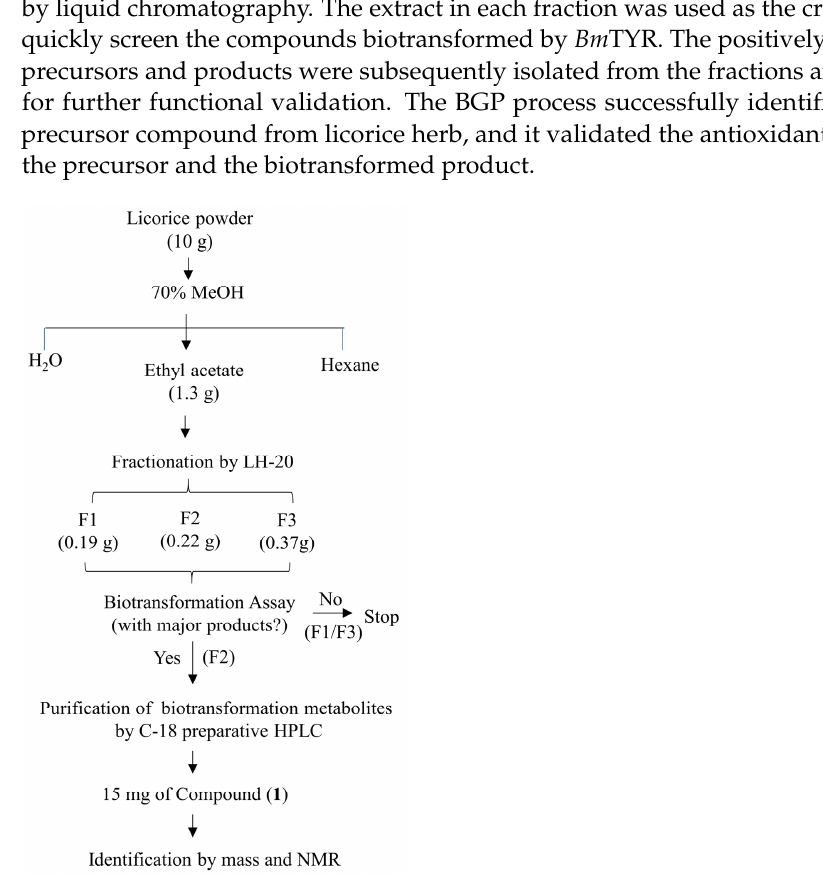
Figure 1. Flowchart of the biotransformation-guided purification (BPG) of a commercial licorice herb.